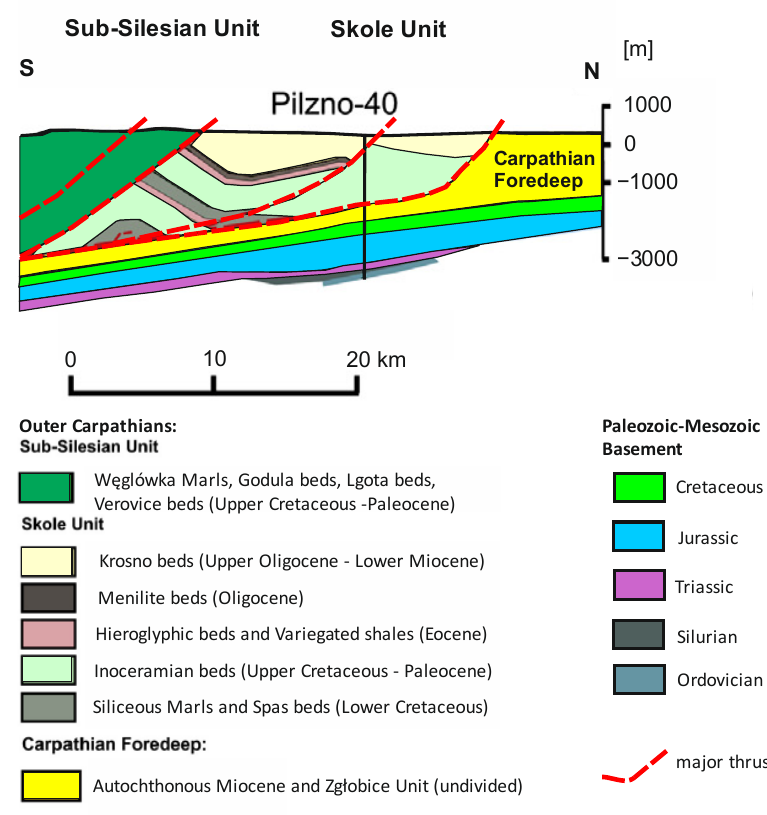
Figure 2. Simplified cross-section perpendicular to Carpathian orogenic front modified after [3,30,32,38].